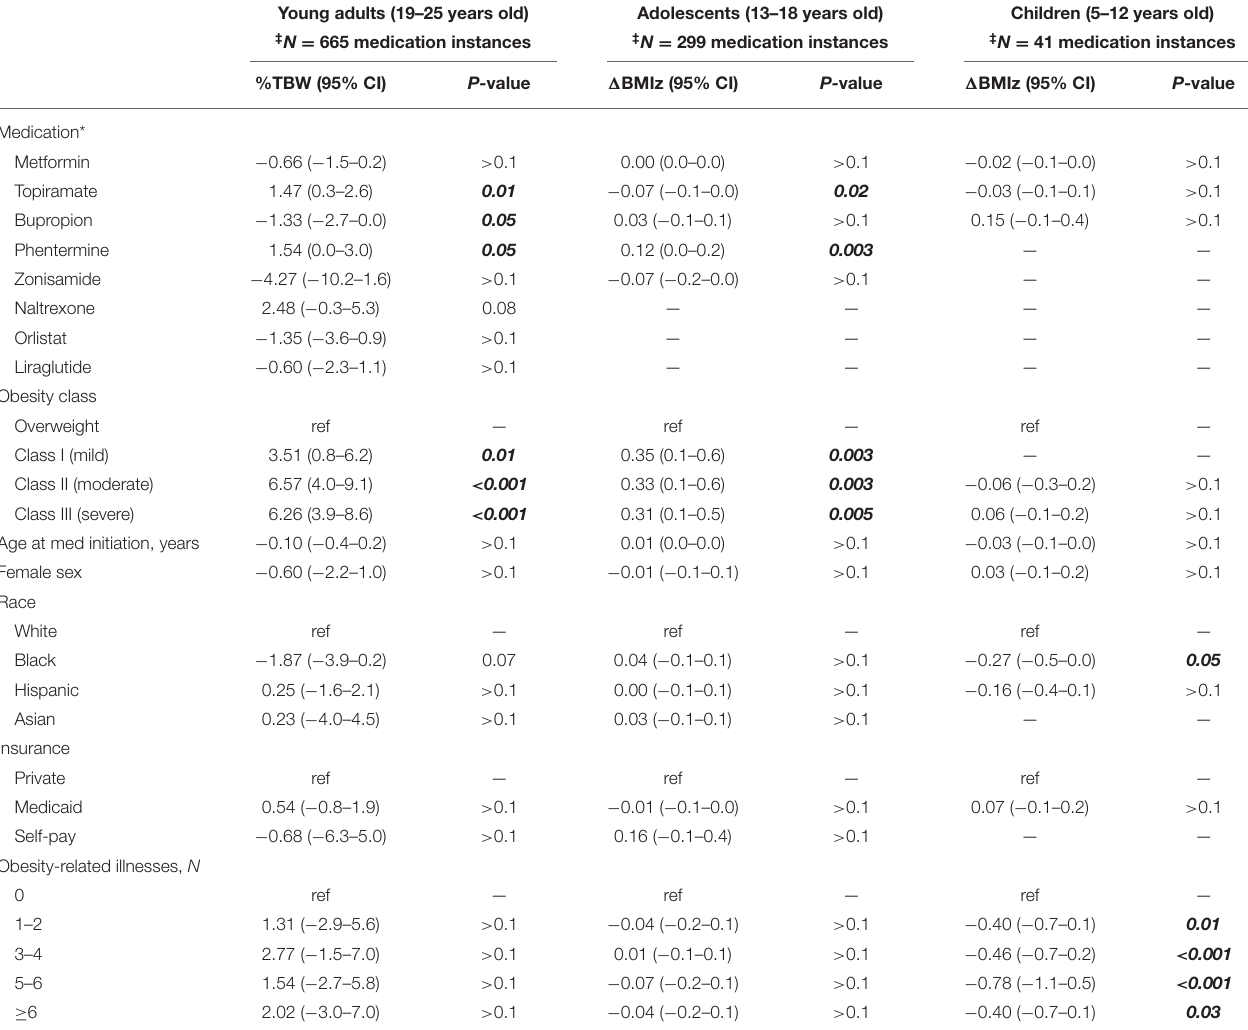
* Coefficient indicates difference between respective medication and the overall frequency-weighted mean. ‡ N, patients with both pre-medication and post-medication weights recorded in chart. ref, reference group. Bold and italic value represents means-statistically